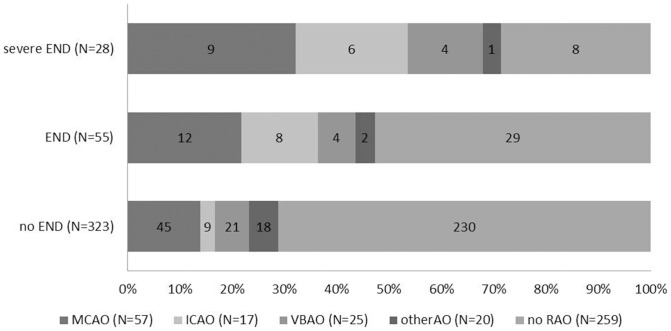
The distribution of occlusion sites according to END type.
MCA and ICA occlusions contributed most frequently to severe END. (Abbreviation: MCAO, middle cerebral artery occlusion; ICAO, internal carotid artery occlusion; VBAO, vertebrobasilar artery occlusion; otherAO, other arterial occlusion; no RAO, no relevant arterial occlusion).